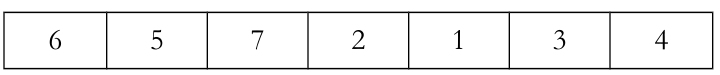
Figure 2. The structure of a response for a problem with seven jobs and two machines in the first station and three machines in the second